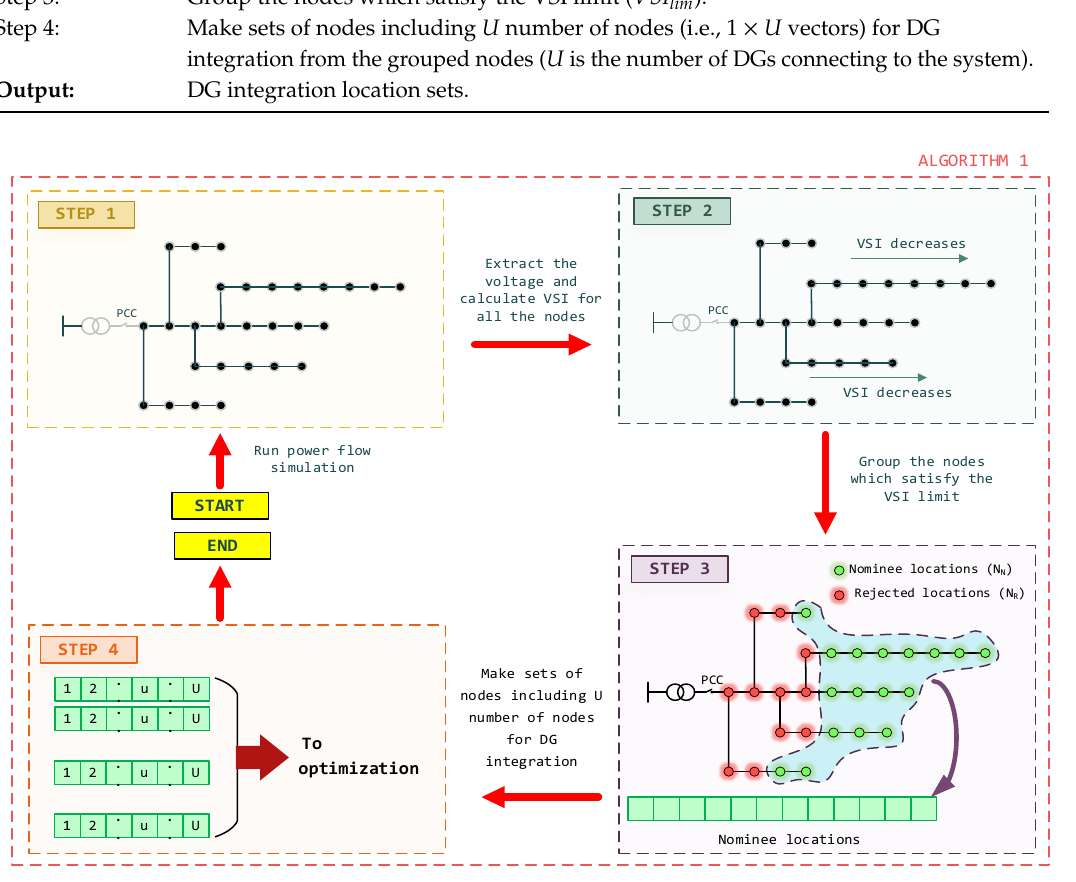
Figure 3. Generation of DG integration nodes using a VSI based method—Algorithm 1.